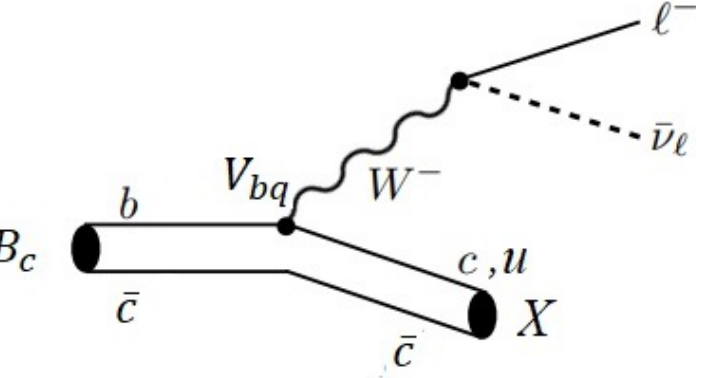
Figure 3. SM contribution for B c → Xl ν l where X = η c , J / ψ , D ( D ∗ )